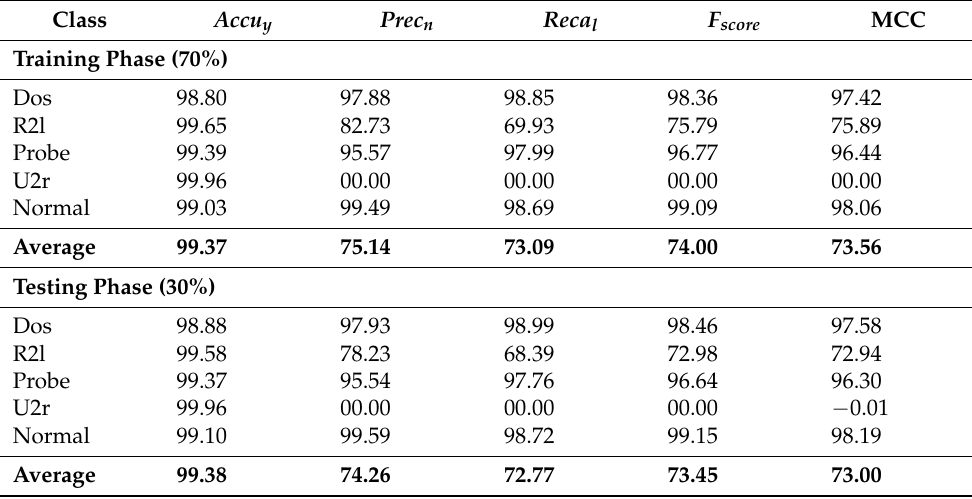
Table 3. Result analysis of IMFL-IDSCS system under 70:30 of TR/TS databases.